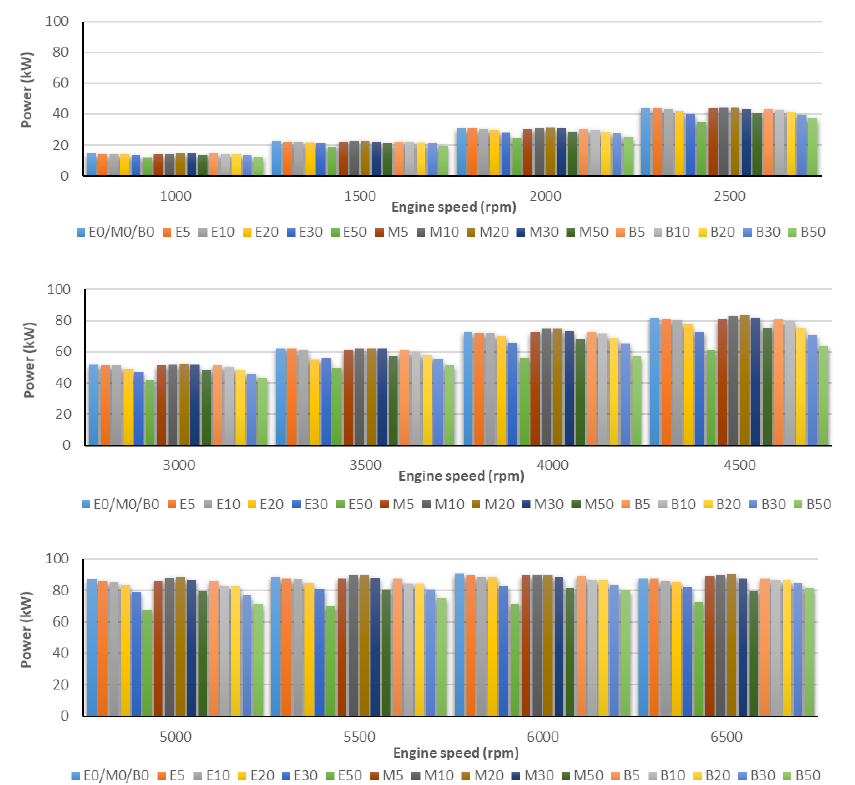
Figure 2. The results for engine brake power obtained from blended alcohol fuels and net gasoline.